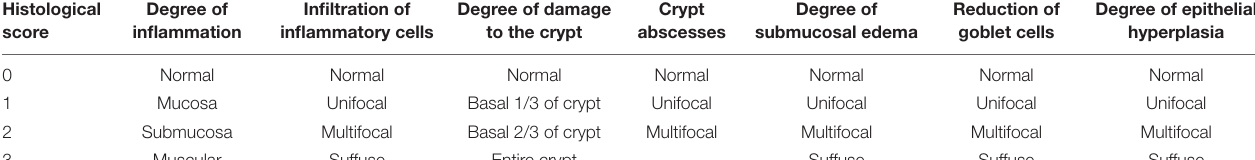
TABLE 2 | Histological scoring system.